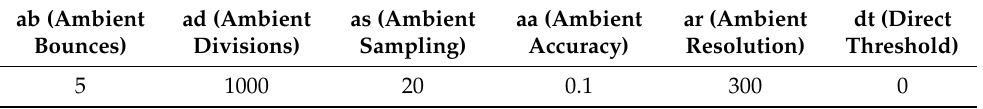
Table 3. The amount of applied parameters for radiance daylight